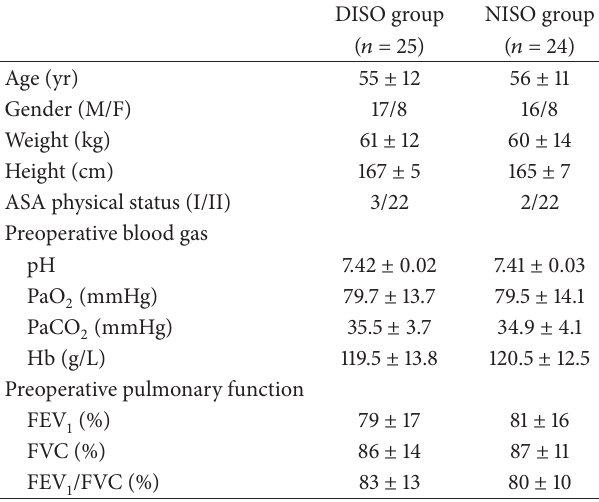
Table 1: General characteristics and preoperative